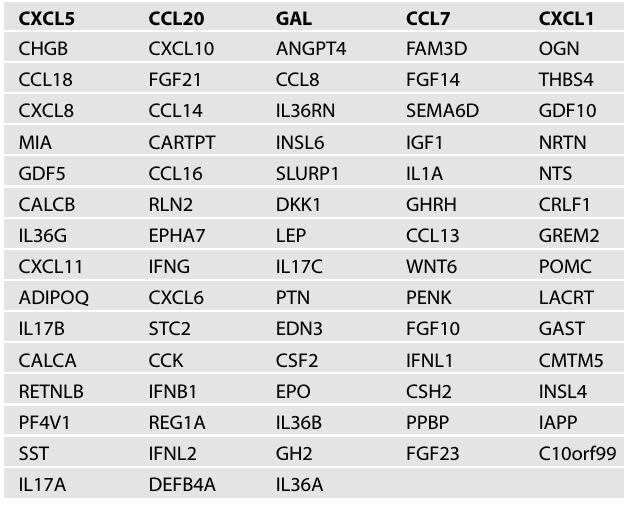
Table 1. The 78 genes analyzed for Fig.